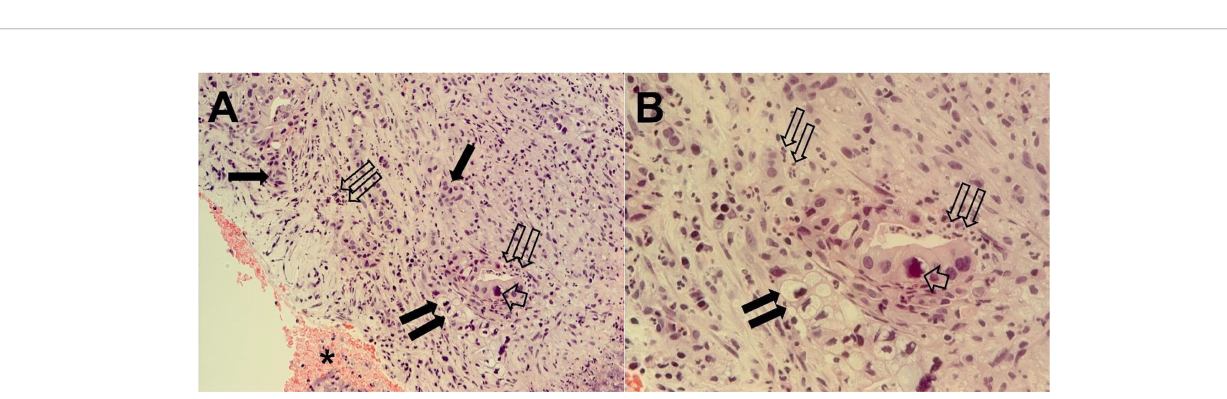
FIGURE 1 | Abdomen CT scan. Single thin arrow, the head pancreatic tumor; short broad arrow, tumor involvement of the superior duodenal-pancreatic artery; twin open arrows, tumor involvement of the portal vein near to the spleno-portal